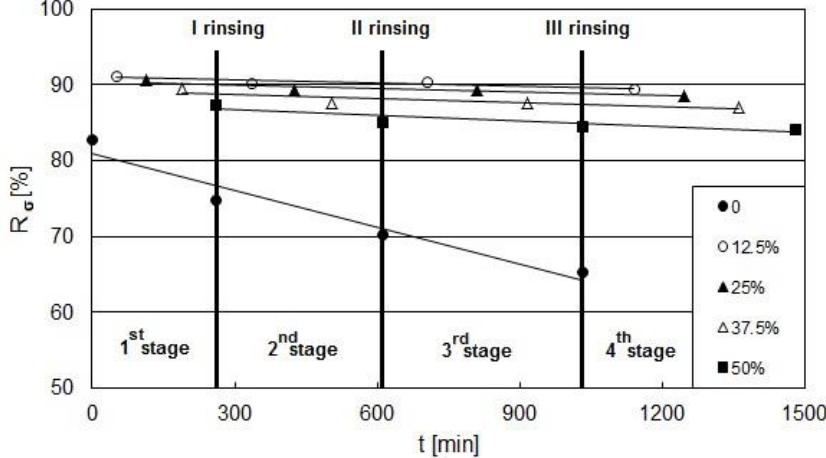
Figure 11. Reduction in conductivity ( R σ ) at different concentrate ratio (CR) vs. time during multi- stage reverse osmosis of the MTW containing a nonionic surfactant (N-S3) (AG Osmonics mem- brane).